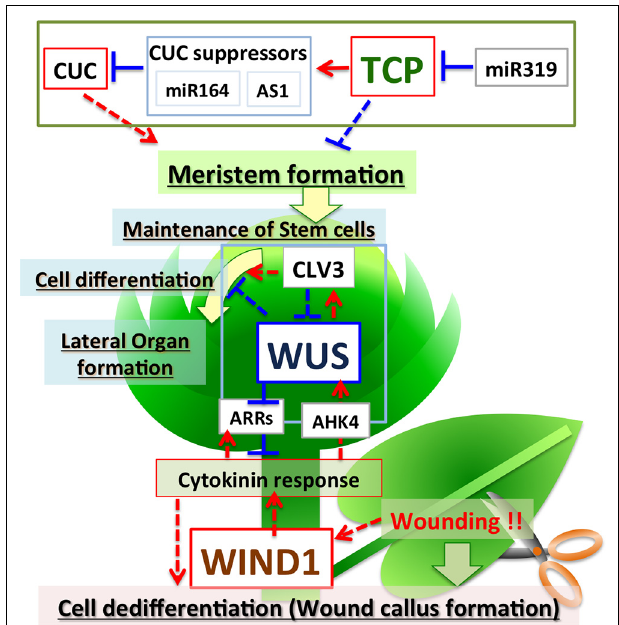
FIGURE 1 | Regulation of plant cell fate byTCPs,WUS, andWINDs. TCPs negatively regulate meristem formation via direct activation of miRNA164 and AS1, which repress CUC s. miR319 negatively regulates expression of TCP s. WUS encodes a transcriptional repressor, but positively regulates cytokinin signaling by suppressing the expression of ARRs to maintain the stem cell population in the shoot meristem. Feedback regulation betweenWUS and CLVs fine-tunes the maintenance of stem cell populations and meristem size.WINDs are induced by wounding, activate cytokinin signaling, and positively regulate de-differentiation to promote callus formation in wounded tissues. Red arrows indicate positive regulation and blue lines indicate negative regulation. Solid lines indicate direct regulation and dotted lines indicate indirect